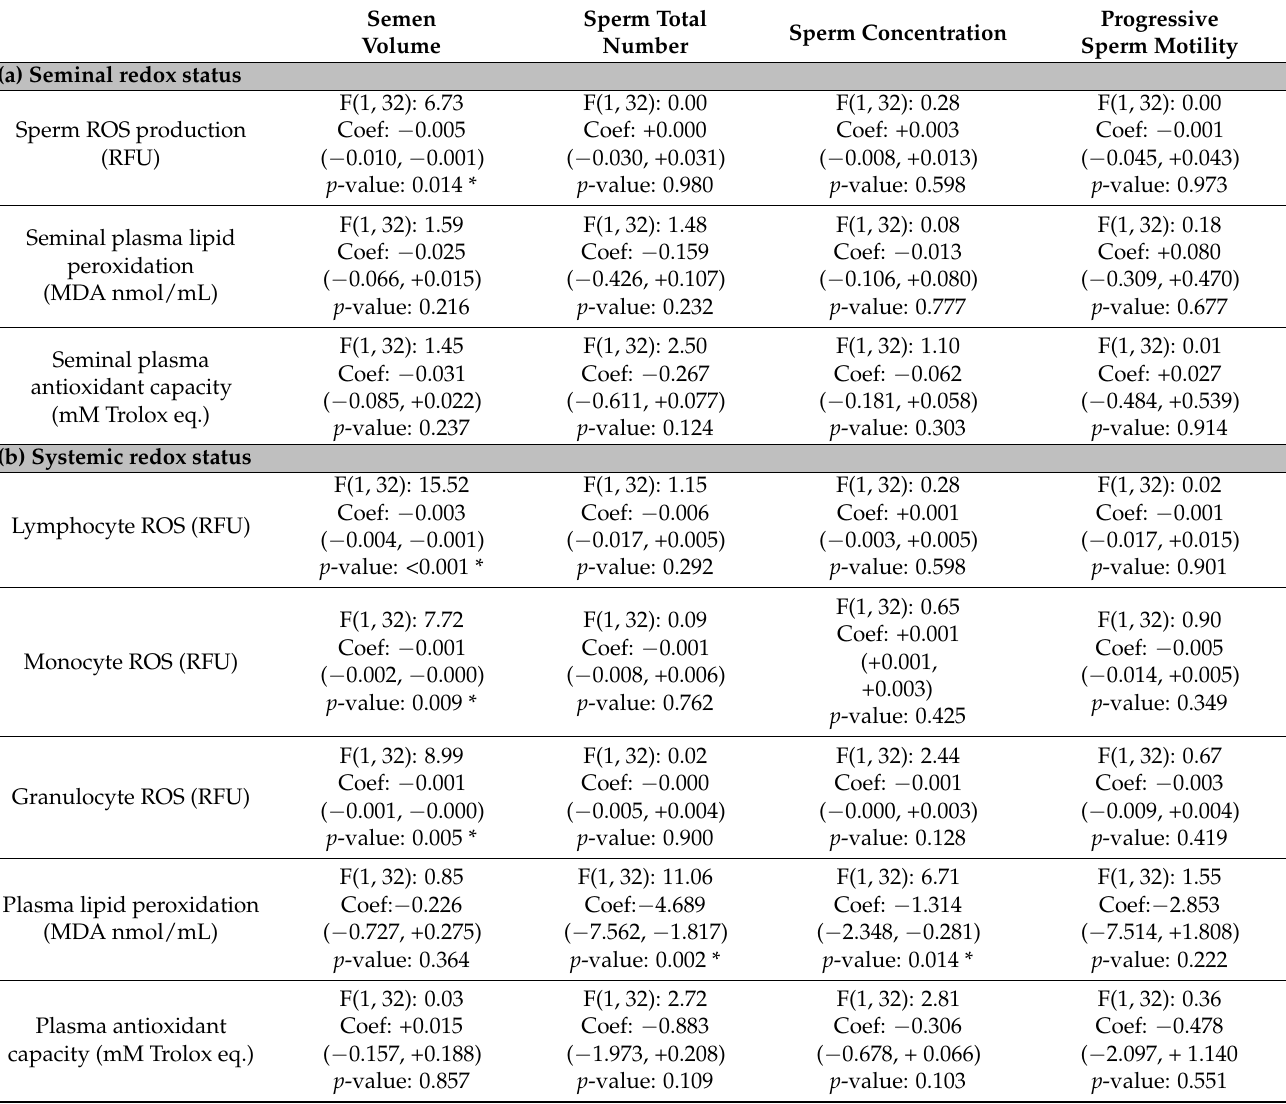
Table 3. Linear regression analyses between seminal (a) and systemic (b) oxidative stress parameters and sperm volume, total number, concentration, and motility, among the 34 infertile patients. Progressive Semen Sperm Total Sperm Concentration Sperm Volume Number